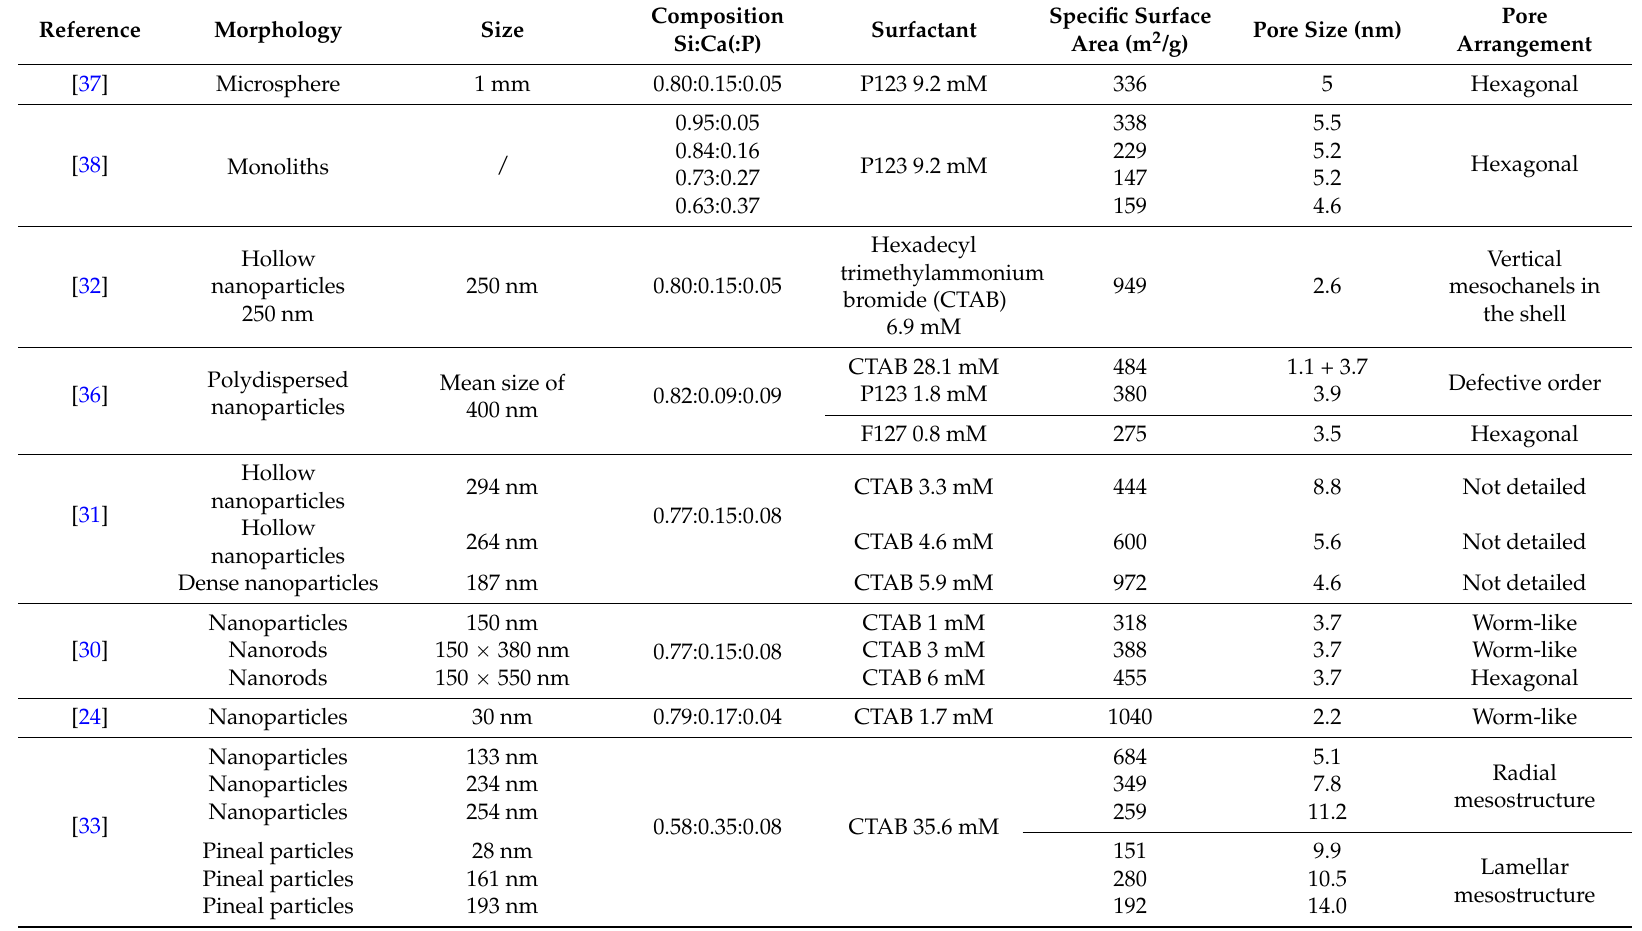
Table 2. Morphology, composition, specific surface area, pore size and arrangement of mesoporous bioactive glasses from the literature, along with the surfactant used for their